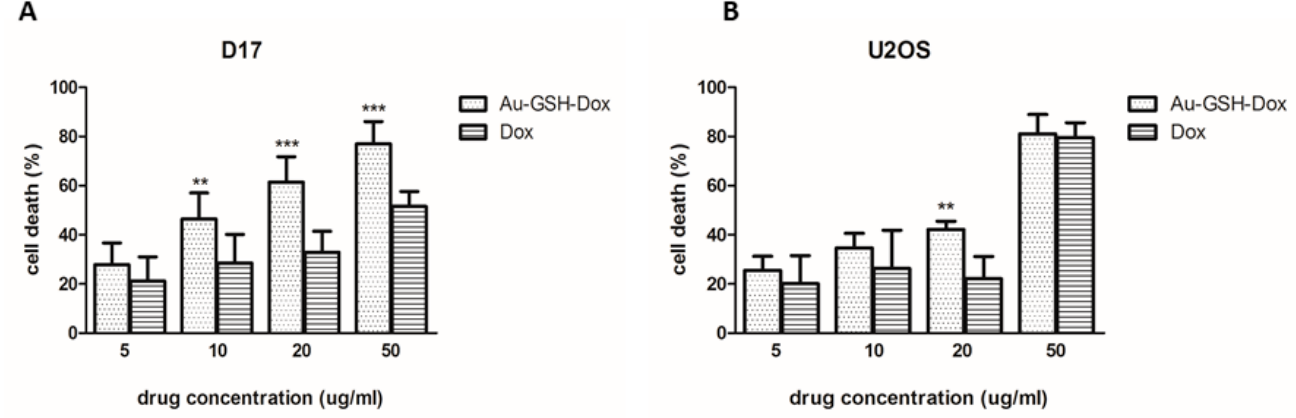
Figure 4. Effect of the tested substances (Au-GSH-Dox and Dox) on the mortality of the tested cell lines: D17 ( A ) and U2OS ( B ). ** p ≤ 0.01 and *** p ≤ 0.001 were interpreted as highly significant.